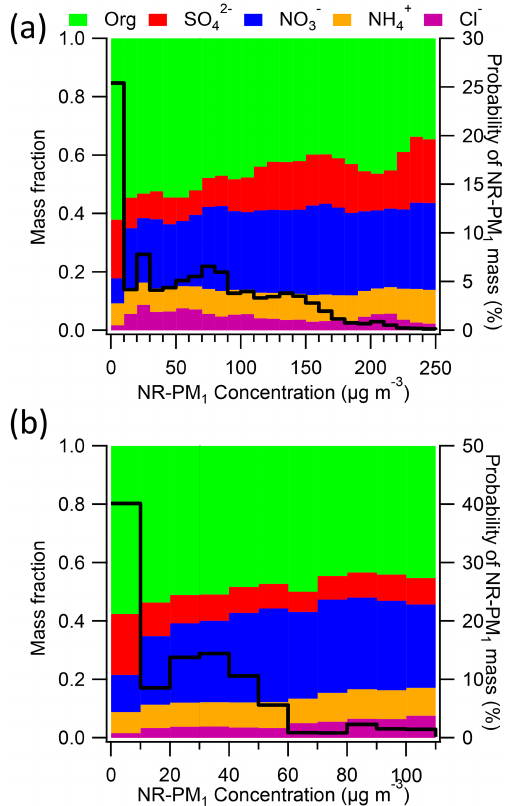
Figure 5. Submicron aerosol composition as a function of NR-PM 1 mass loadings (a) before APEC and (b) during APEC. The solid line shows the probability of NR-PM 1